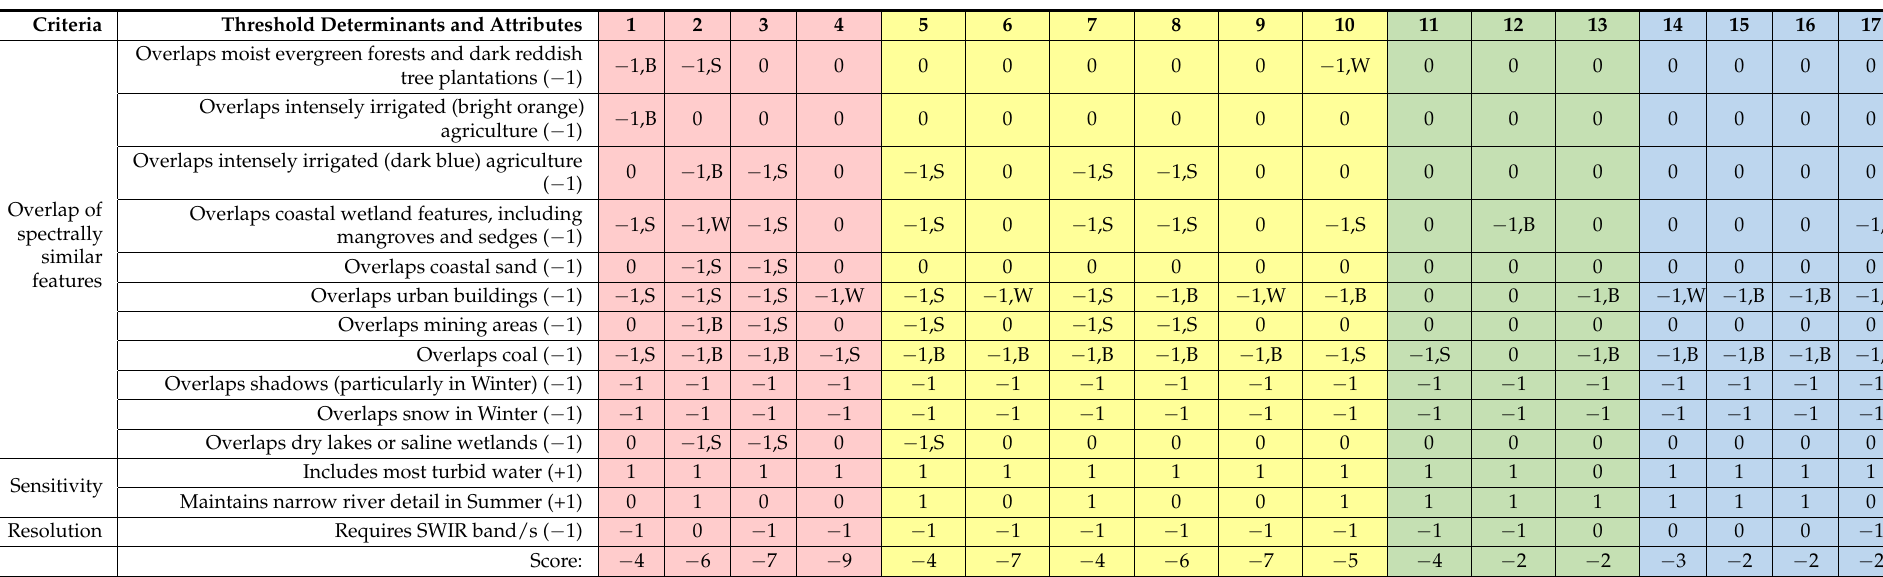
Table 4. Decision matrix for 17 candidate water indices in either Summer or Winter seasonal conditions. Colour-related descriptions refer to visualization in R,G,B: NIR , SWIR1, Red. The seasons displaying the problems are labelled as: S (Summer), W (Winter), or B (Both Summer and Winter). The most positive score indicates best overall